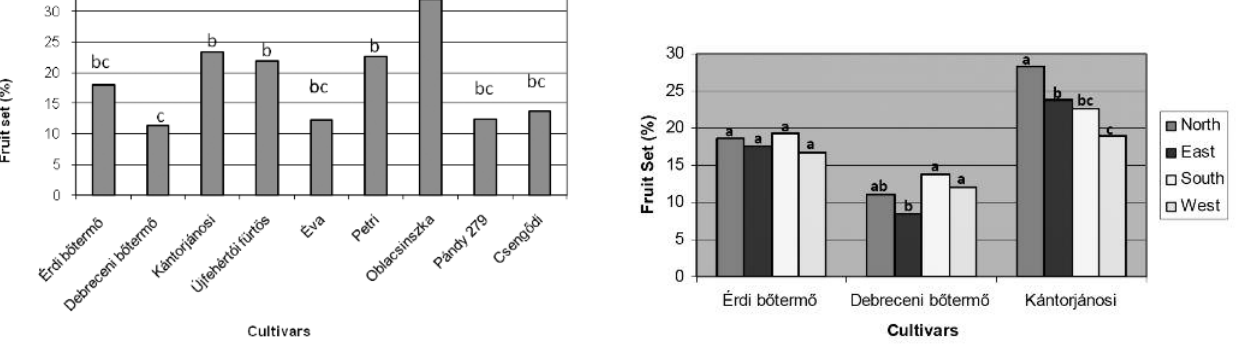
Figure 1. Final fruit set of Hungarian sour cherry cultivars (Újfehértó 2008) Figure 2A. Fruit set of sour cherry cultivars on different direction of the